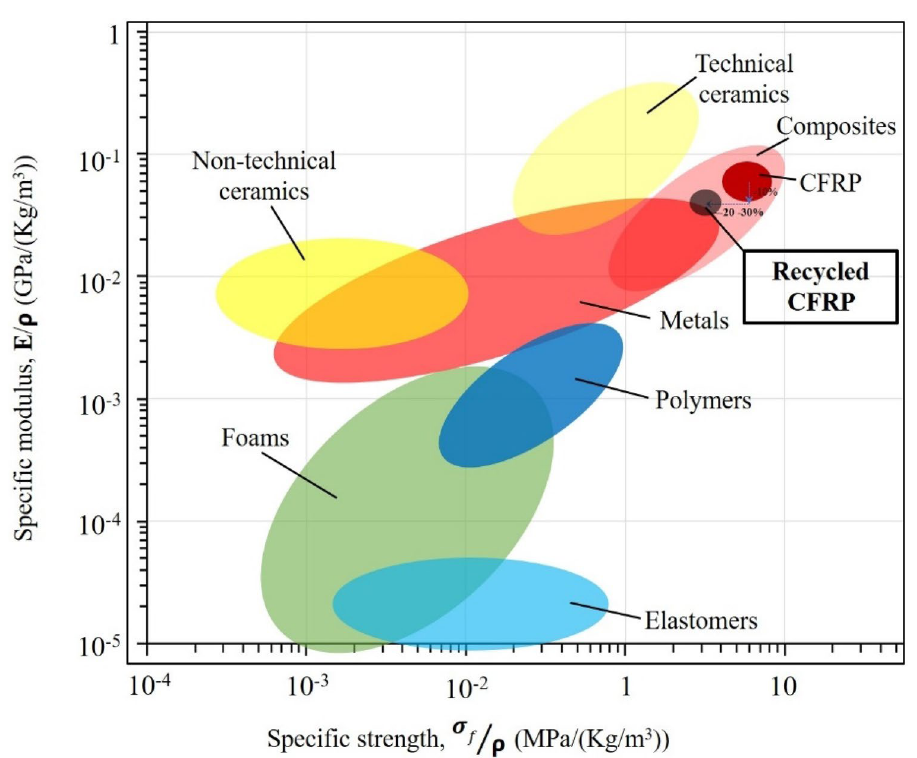
Figure 16. Schematic material property chart (Ashby diagram) of specific modulus versus specific strength showing the positioning of the different families of materials involving the recycled panel addressed in this